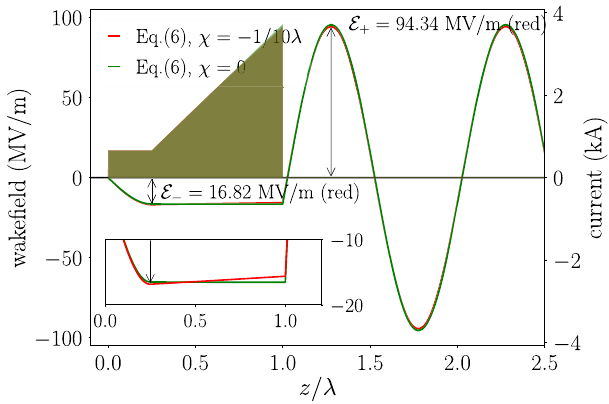
accelerator.FIG. 1. Doorstep distributions described by Eq. (6)